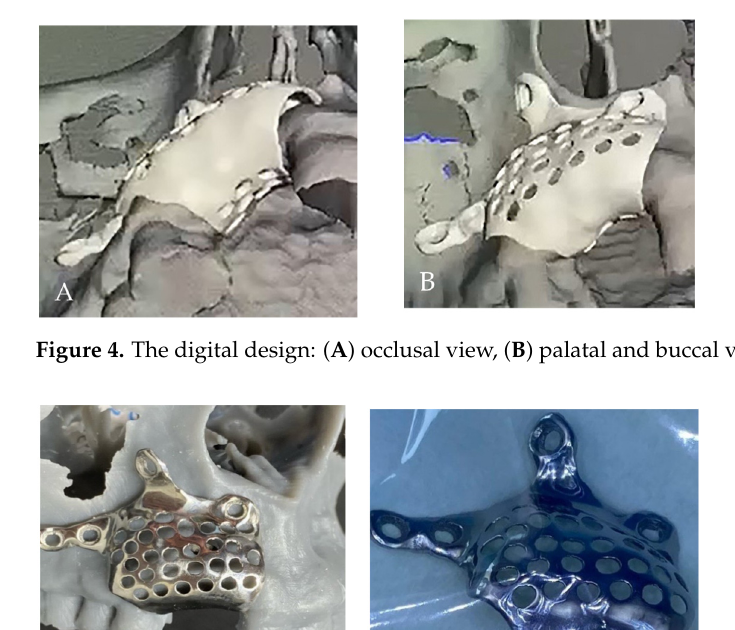
Figure 3. The surgical treatment plan steps.